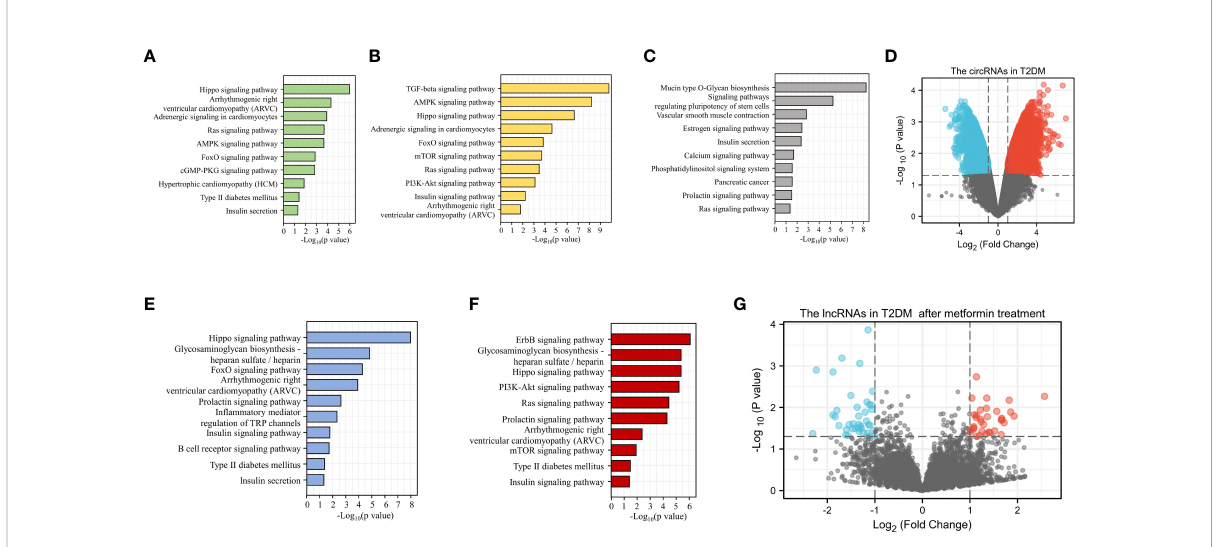
FIGURE 3 Bioinformatic analysis of the potential role of ncRNAs in DM. KEGG analysis of the target genes of miRNAs up-regulated (A) or down-regulated (B) in T1DM. KEGG analysis of the target genes of differentially expressed miRNAs in T2DM (C) . Differential expression of circRNA in T2DM (D) . KEGG analysis of the target genes for up-regulated (E) or down-regulated (F) miRNAs in GDM. LncRNAs with altered expression in T2DM patients after metformin treatment (G)